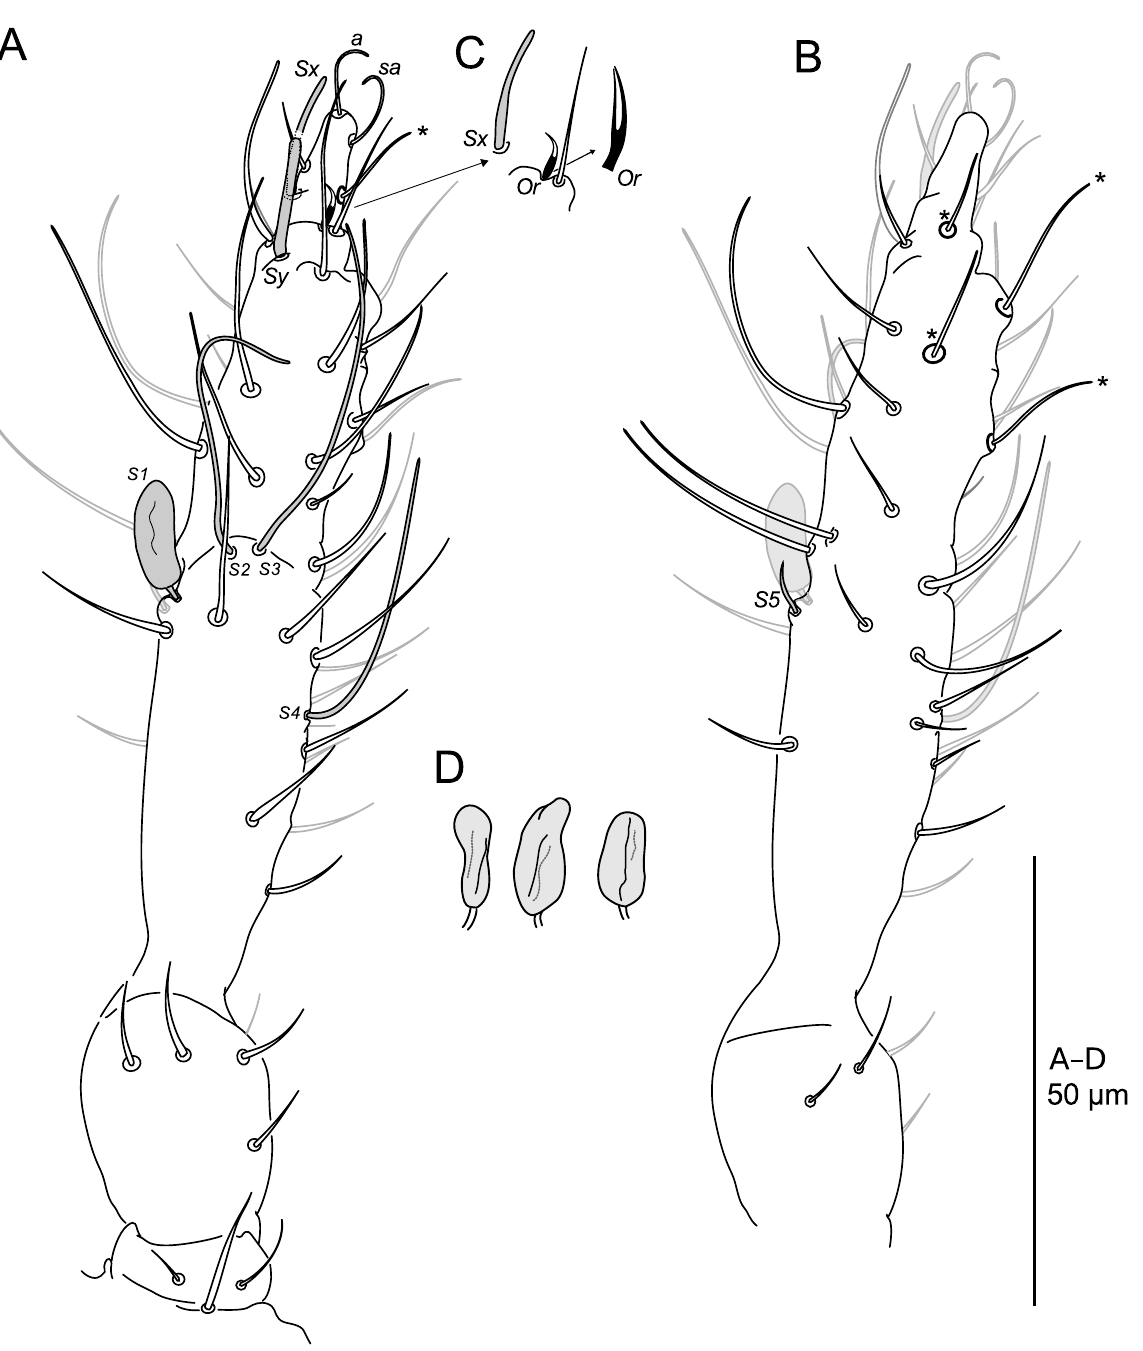
Fig. 3. Spinaethorax adamantis sp. nov. A–D . Chaetotaxy of the antenna. A . Dorsal side. B . Ventral side. C . Focus on S-chaeta Sx and Organite Or with enlargement of the latter. D . S-chaeta S1 , different aspects. Asterisks indicate modified chaetae. Chaetae implanted on the other side represented with gray